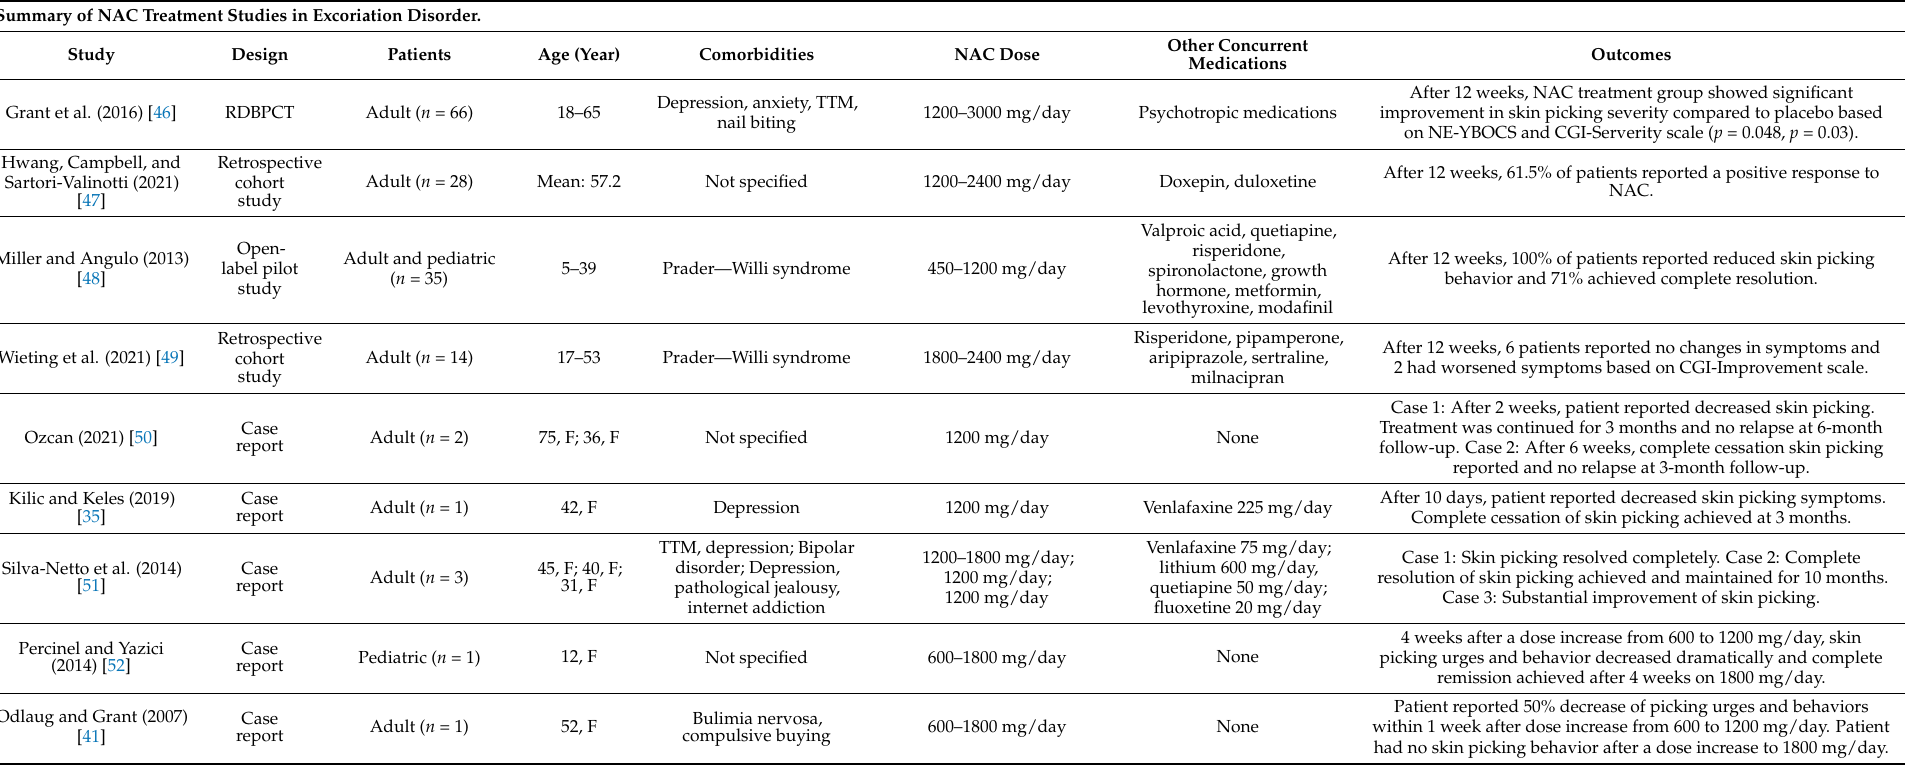
Table 2. Summarizes all NAC treatment studies for excoriation disorder, which includes one adult randomized double-blind controlled trial, two adult retrospective cohort studies, one adult and pediatric open-label pilot study, and five case reports. Summary of NAC Treatment Studies in Excoriation